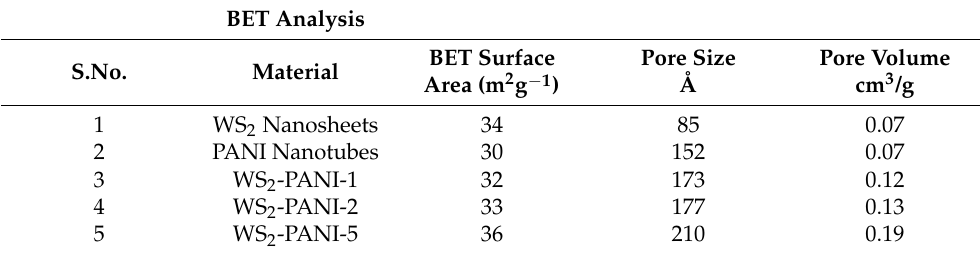
Figure 5. Nitrogen adsorption–desorption isotherms for ( a ) bare WS 2 , ( b ) bare PANI, ( c ) WS 2 -PANI-1, ( d ) WS 2 -PANI-2, and ( e ) WS 2 -PANI-5. Table 1. BET and BJH Adsorption Cumulative Pore Volume analysis of WS 2 Nanosheets, PANI Nanotubes, and